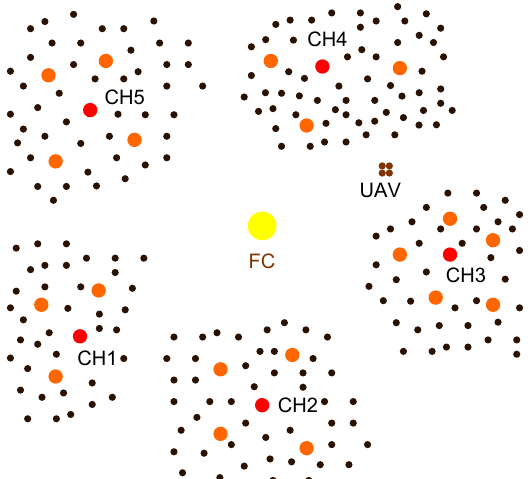
Figure 1. The whole multi-robot system includes a fusion center (FC) and five clusters of robots around FC. Red dots are the cluster head (CH) robots whereas the orange ones are the remaining robots which collects (environmental monitoring) data from the sensors (the black dots) in their cluster and send their data to the CH robot of their cluster. There are 19 robots in total and the UAV in the system. The UAV initially stands on the FC to charge its battery. After the UAV collects data from all CH robots directly or indirectly, it returns to FC to send all data to FC and recharge its battery for the next